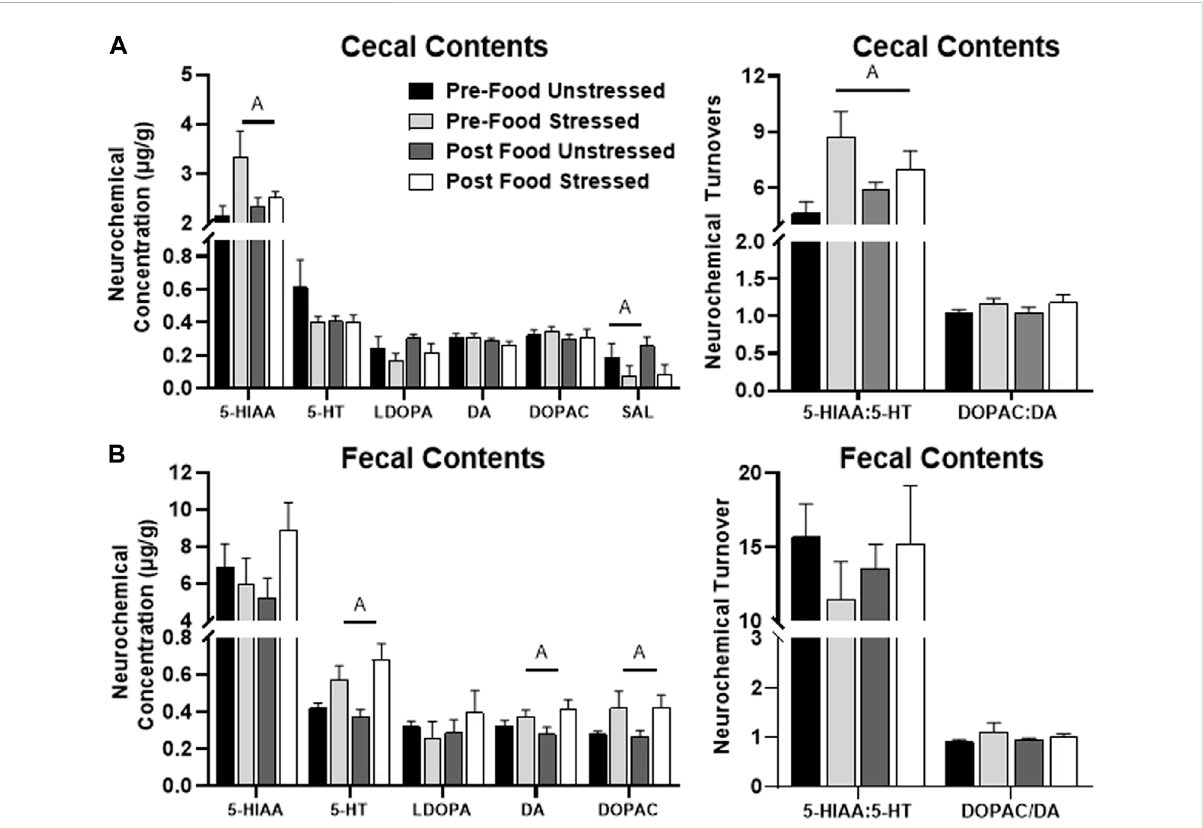
FIGURE 4 Monoamine-related neurochemical changes in the intestinal contents 48 h after stress exposure. (A) Stress increased 5-HIAA and decreased SAL concentrations (left panel), as well as elevated 5-HT turnover measures (right panel) in the cecal contents. (B) Stress increased 5-HT, DA, and DOPAC concentrations in the fecal contents (left panel). ±S.E.M. signi fi cant main effect of stress (A) or food access (B) from Two-Way ANOVA. Signi fi cance p < 0.05. Sample size n = 9 per group, except Post Food Stress group n =